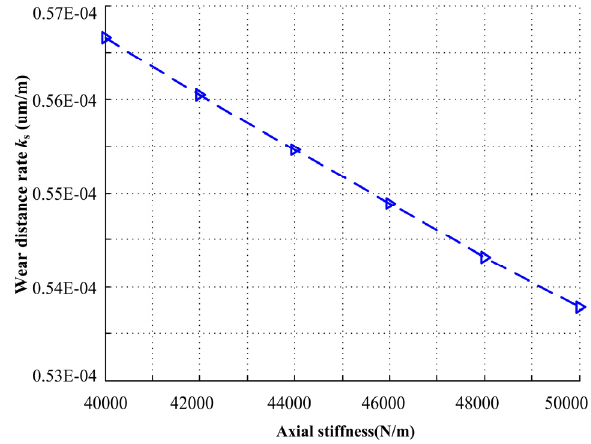
Figure 16. Wear distance rate under different axial stiffness.